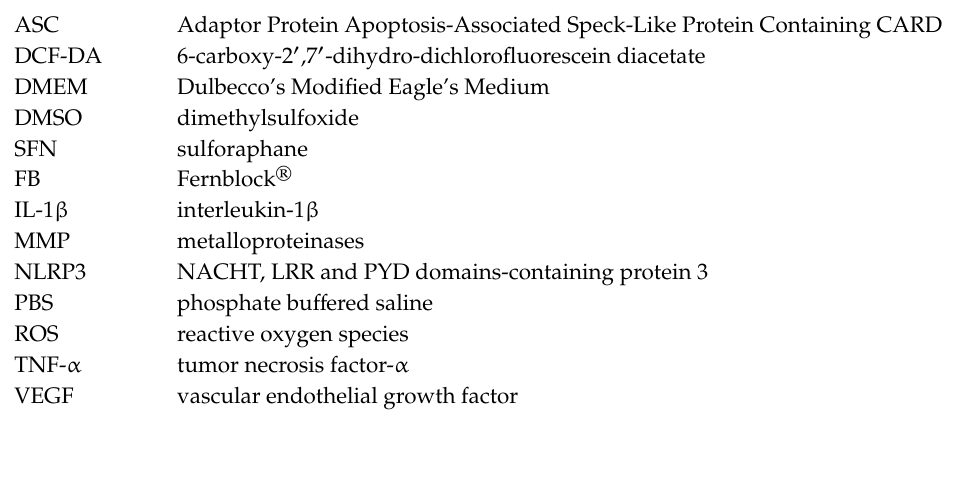
Figure S1: E ff ect of a 24 h-treatment with di ff erent concentrations of SFN (2.5–10 µ M) and FB (1 mg / mL), alone and in combination, on ROS production in HaCaT and NCTC 2544 keratinocytes in basal conditions and in the presence of 100 µ M H 2 O 2 as a pro-oxidant stimulus. (*: significantly di ff erent from respective control, p < 0.05, One-way ANOVA followed by Tukey’s test). In panels A, B and D, is shown the CI obtained following the treatment with SFN and FB (10 µ M SFN and 1 mg / mL FB). The interaction was considered significant